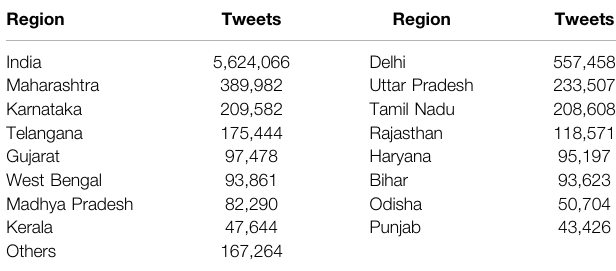
TABLE 1 | CoronaIndiaDataset statistics.